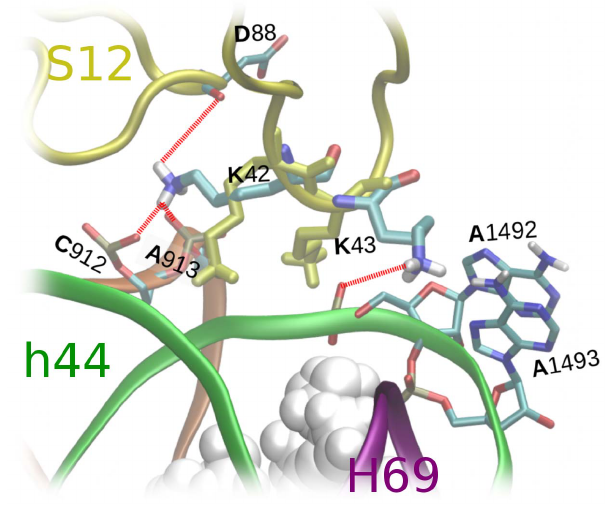
Figure 7. Conformations of K42 and K43. The initial structure is yellow and an exemplary final conformation is colored by atom type. The most frequent H-bonds in the MD trajectories are marked by red dashed lines. Paromomycin is shown as a space-filling vdW represen- tation. doi:10.1371/journal.pone.0111811.g007 PLOS ONE |